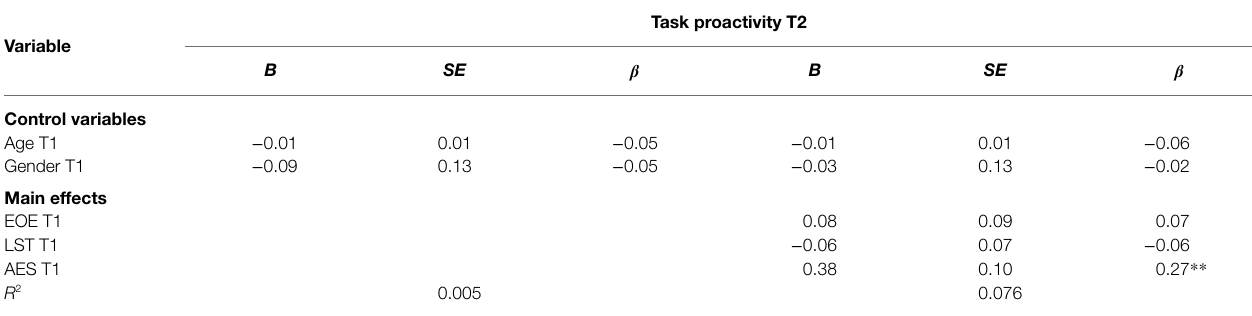
TABLE 2 | Results of the hierarchical multiple regression analysis with task proactivity at T2 as dependent variable (Study 1).